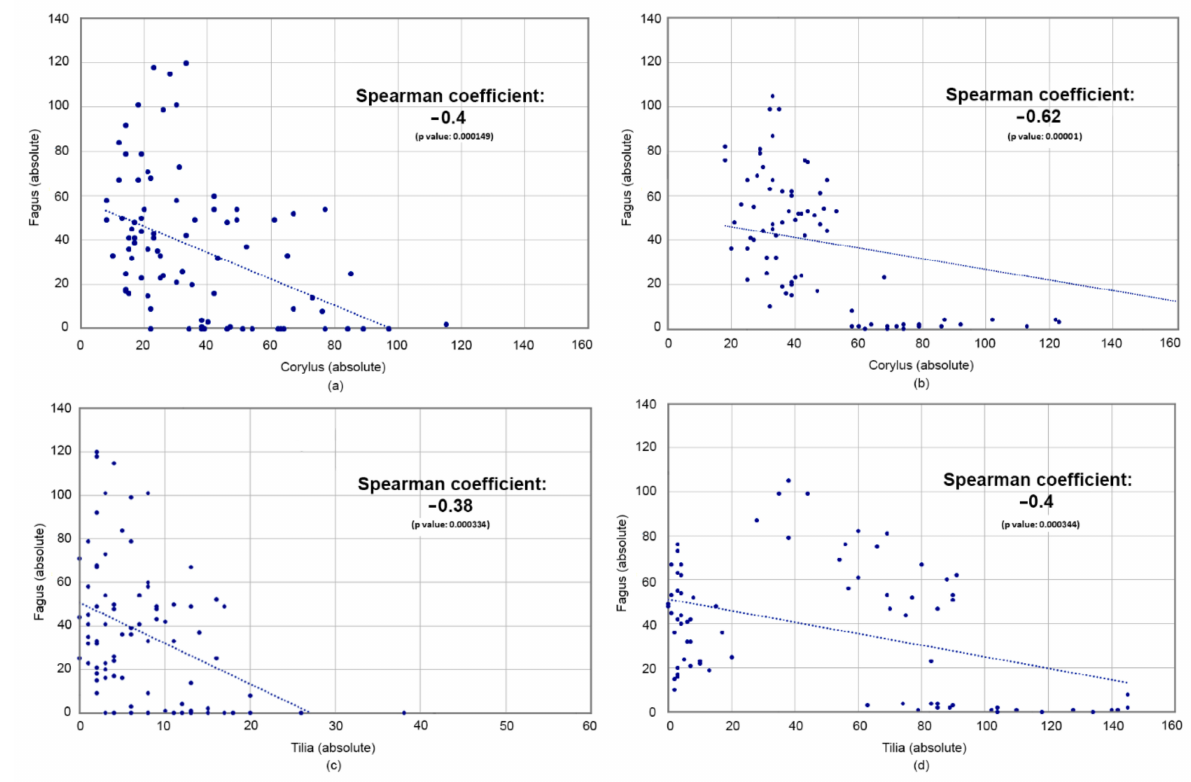
Figure 8. Scatterplots of selected tree taxa with linear trendlines ( a ) Fagus - Corylus at Moenchborn; ( b ) Fagus - Corylus at Heftrich, ( c ) Fagus - Tilia at Moenchborn (modified x-axis), ( d ) Fagus - Corylus at